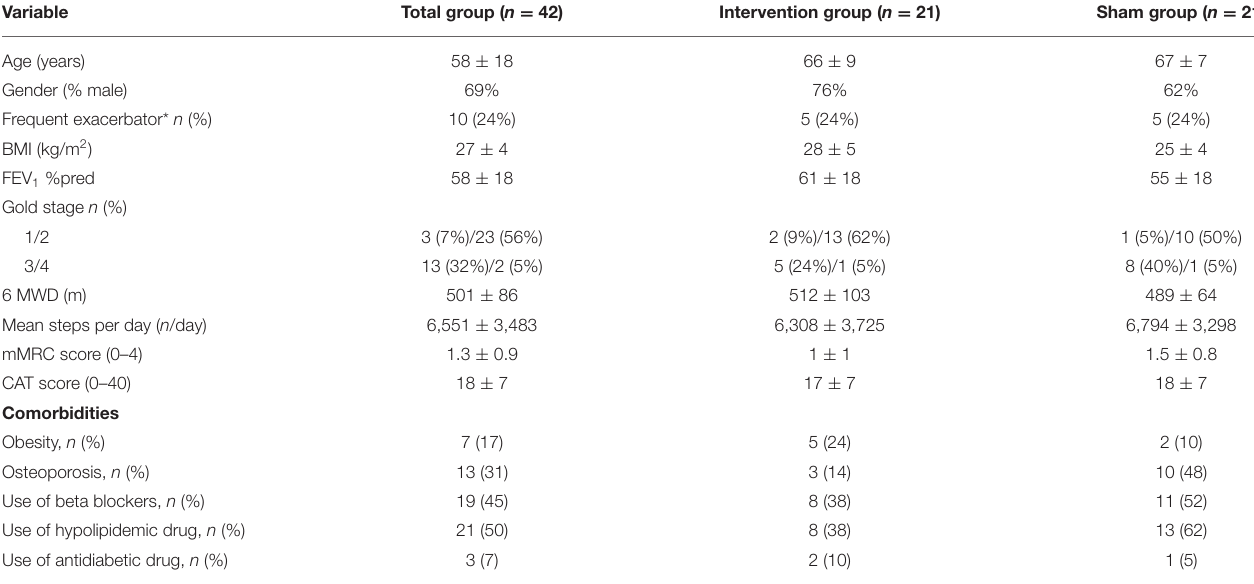
TABLE 1 | Baseline characteristics [mean ± SD or n (%)] (%) for complete sample and intervention and sham group separately.